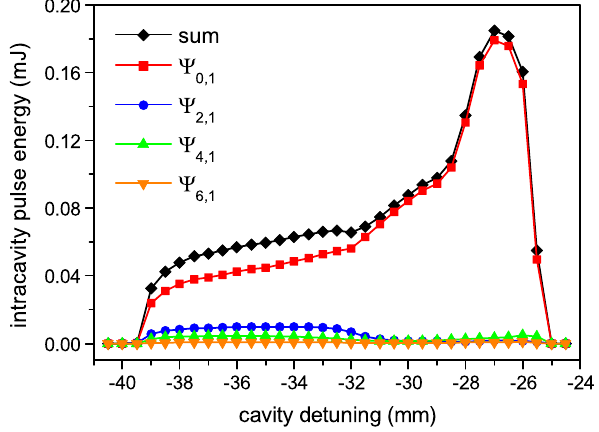
FIG. 9. Same as in Fig. 3 but when mirror width was taken to be 20 cm.